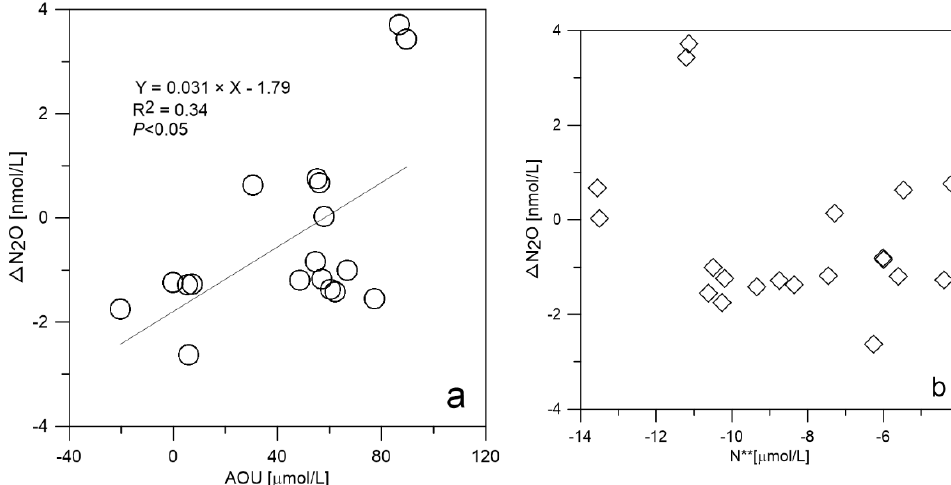
Figure 5. The relationship between N 2 O and AOU ( a ) N 2 O and N** ( b ) in the cold bottom water of the NBES.